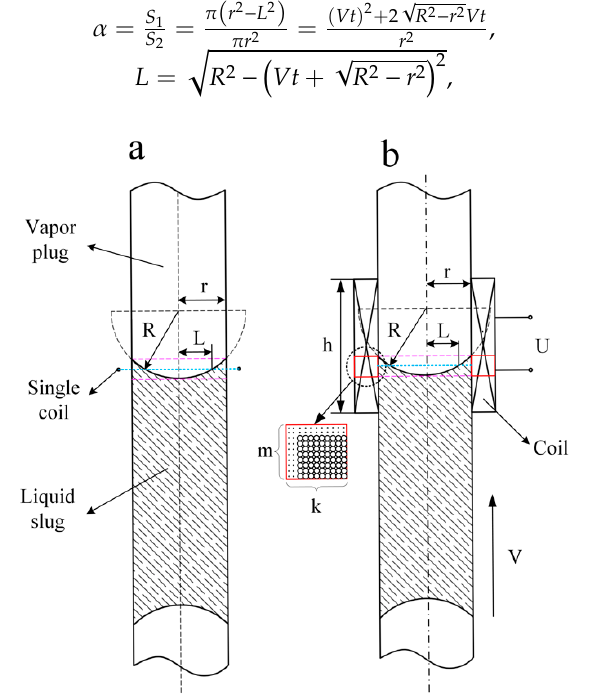
Figure 4. Schematic diagram of theoretical calculation model of induced electromotive force: ( a ) Liquid slug passing through the single coil; ( b ) liquid slug passing through the multi-turn coil.